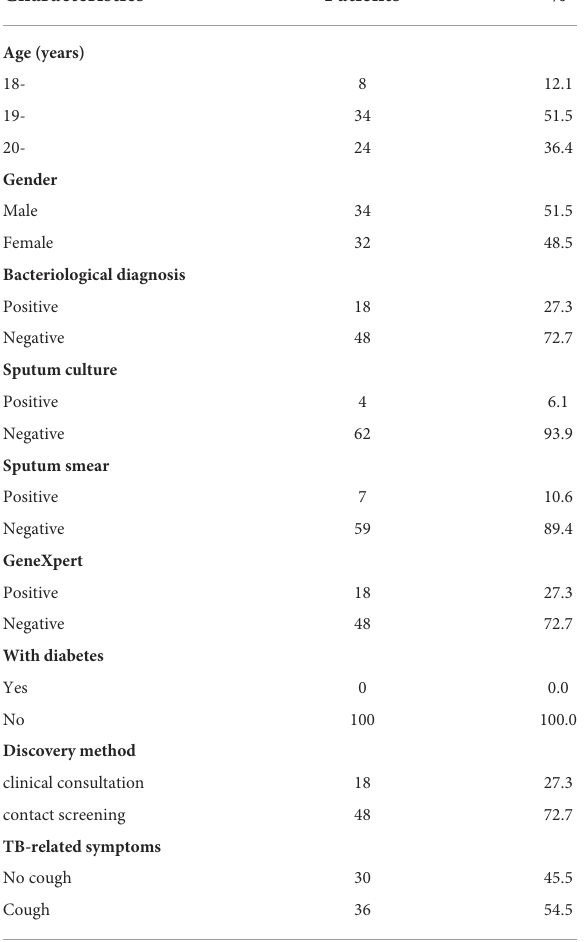
TABLE 3 Attack rates of active tuberculosis in this school tuberculosis outbreak, Jiangsu, China.